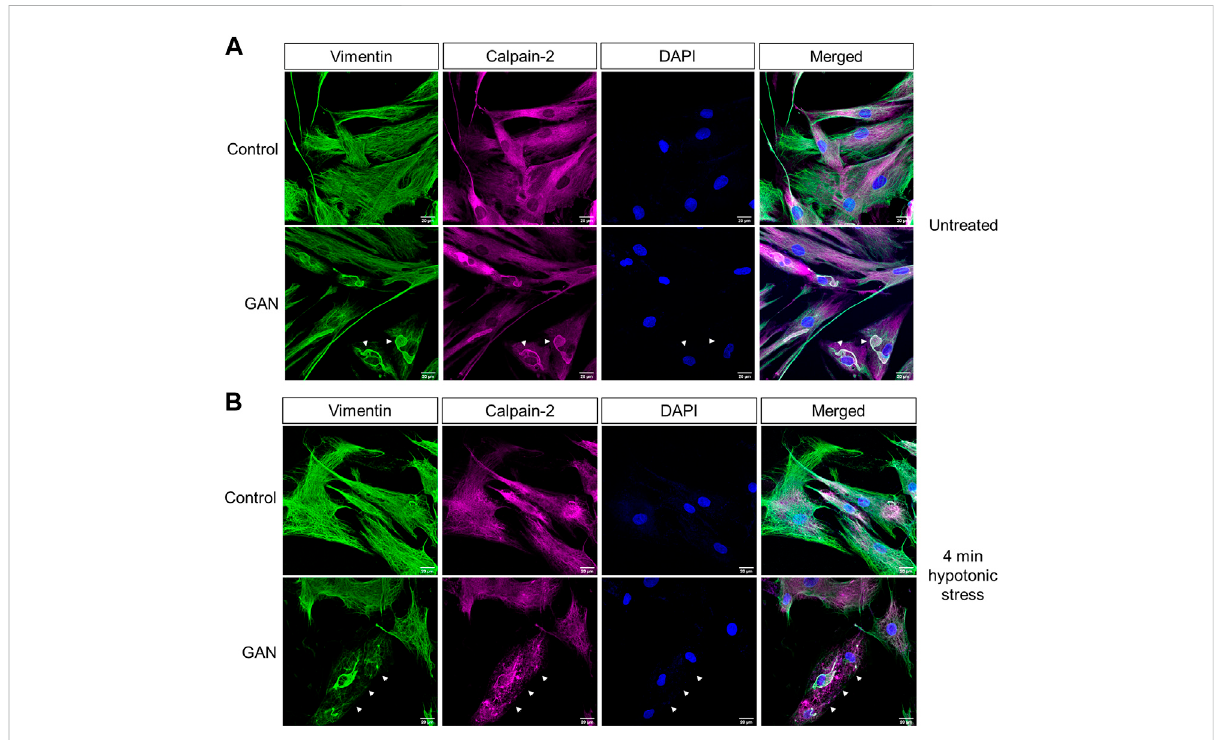
FIGURE 4 Calpain-2 colocalizes with perinuclear vimentin aggregates and undergoes cytoplasmic redistribution upon hypotonic stress exposure. (A) Calpain colocalizes with vimentin aggregates in untreated GAN fi broblasts. Immuno fl uorescence analysis of untreated control (56.3; top) and GAN (56.1; bottom) fi broblasts stained with vimentin (green), calpain-2 (magenta), and DAPI (blue); scale bar = 20 μ m. Large perinuclear vimentin aggregates(green)colocalizewithcalpain-2(magenta)inGANpatientcells(whitearrowheads). (B) Calpainredistributionandvimentinnetwork breakdown under hypotonic stress. Immuno fl uorescence analysis of control (56.3; top) and GAN (56.1; bottom) fi broblasts exposed to hypotonic stress for 4 min and stained with vimentin (green), calpain-2 (magenta), and DAPI (blue); scale bar = 20 μ m. Calpain-2 (magenta) becomes more punctate and localized to vimentin fi laments, indicating the selective loss of the vimentin fi lament network as compared to the relative preservation of vimentin aggregates (green) in GAN fi broblasts (white